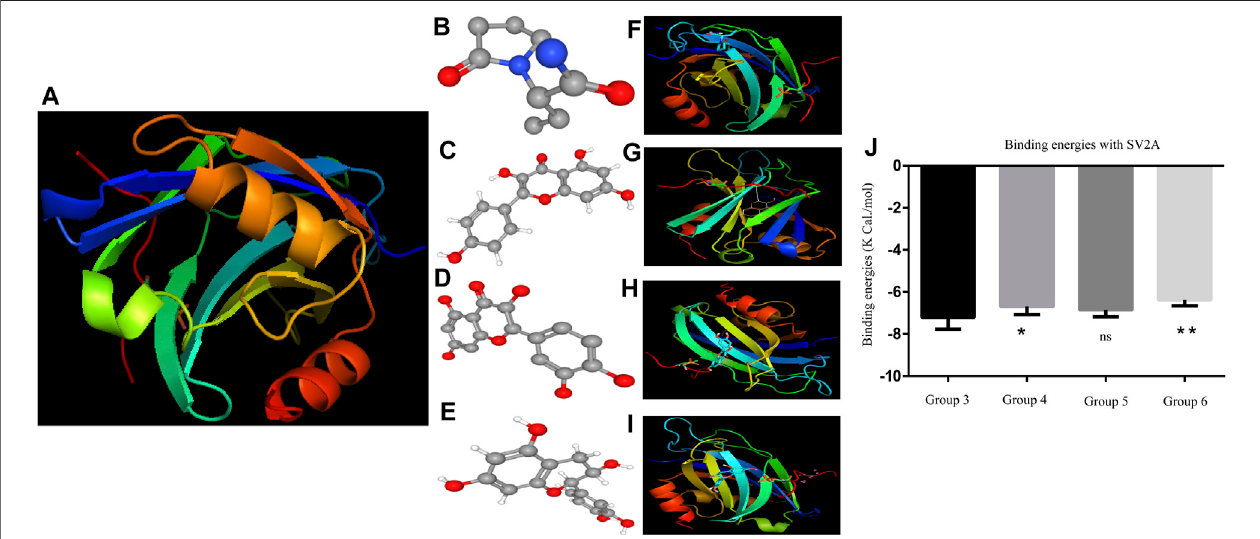
FIGURE 2 | (A) SV2A receptor (B) is the 3D structure of LEV. (C – E) Phyto fl avonoids (kaempferol, quercetin, and catechin) (F – I) showing the protein ligand interaction of LEV, kaempferol, quercetin, and catechin. (J) Graph of the binding energies one-way ANOVA (Moghbelinejad et al., 2016; Verrotti et al., 2020) F (cid:2) 8.130 followed by post hoc Bonferroni ’ s multiple comparison test.* p < 0.01. ** p < 0.05, *** p < 0.0005, and **** p <